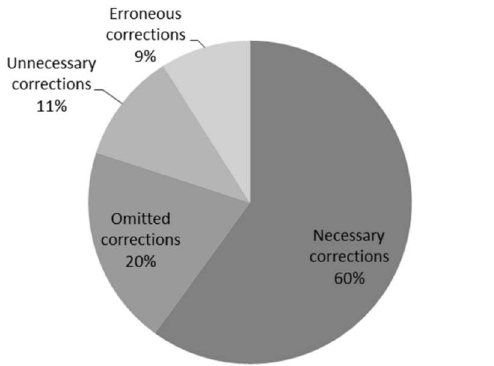
Figure 3. Corrections of the French MT